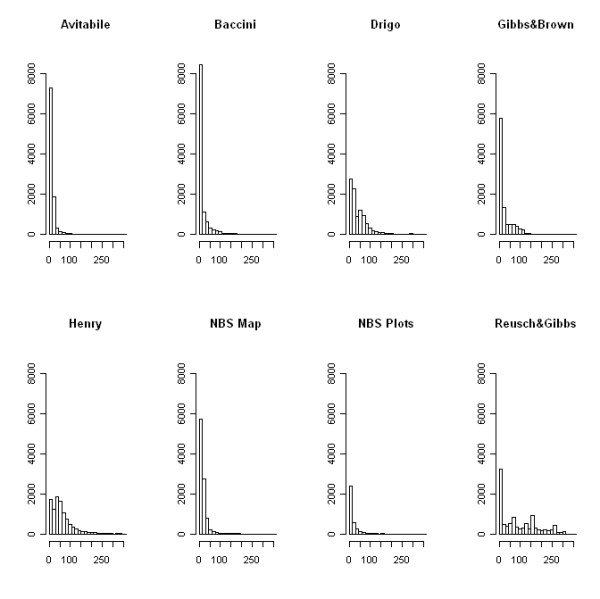
Histograms of the biomass maps and NBS field plots. The histograms represent the frequency (i.e. number of occurrence) (y axis) for each AGB class (x axis). AGB is reported in Mg ha-1. The histograms are derived from maps aggregated at the resolution of the coarser map (5 × 5 Km) for consistent representation of frequency values.